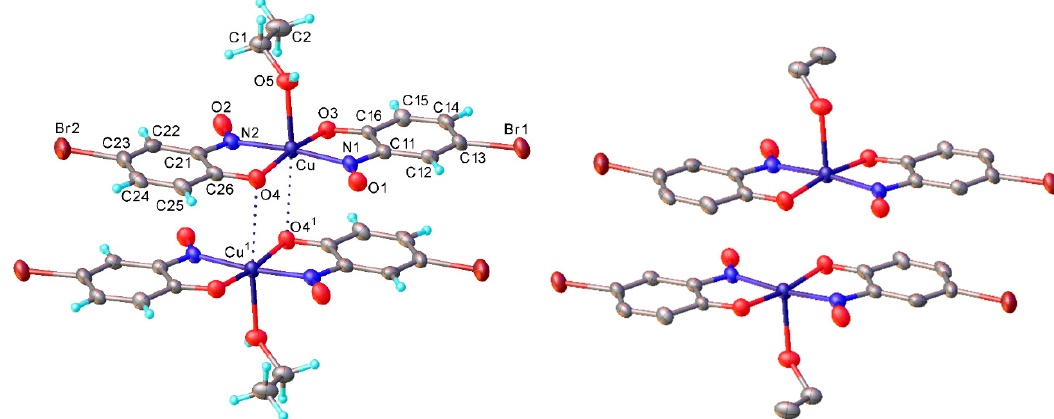
Figure 2. The intermolecular interactions of copper bis (4-bromo-2-nitrosophenolato), 2c crystallised from ethanol-chloroform, shown both with ( left ) the hydrogen atoms simulated using riding models and without ( right ). Mean bond distances Cu-O(phenol) 1.939(5), Cu-N 1.981(6), Cu-O(Et) 2.239(6) Å (cf. in 2a , 1.954(2), 1.988(2) and 2.236(2) Å, respectively). There is a weak intermolecular Cu-O interaction opposite the ethanol ligand (3.196(6) Å in 2c , 3.243(2) in 2a ). Primed atoms are generated by an inversion centre.